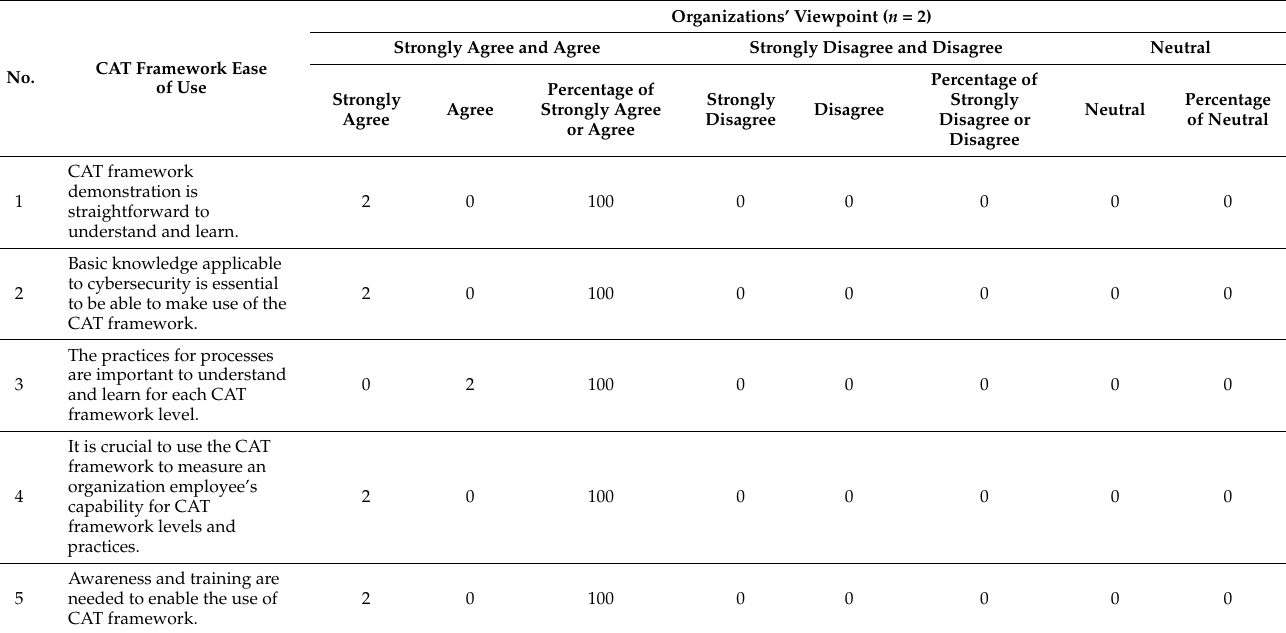
Table 3. CAT framework ease of use evaluation from both organization I and Organization II.